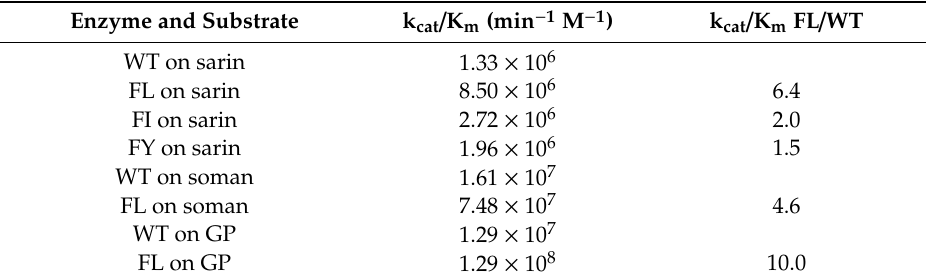
Table 5. Kinetic parameters of wild-type (WT) enzymes and enzymes with genotype Tyr212Phe / Val342Leu (FL) on sarin, soman and 2,2-dimethylcyclopentyl methylphosphonofluoridate (GP) [94].